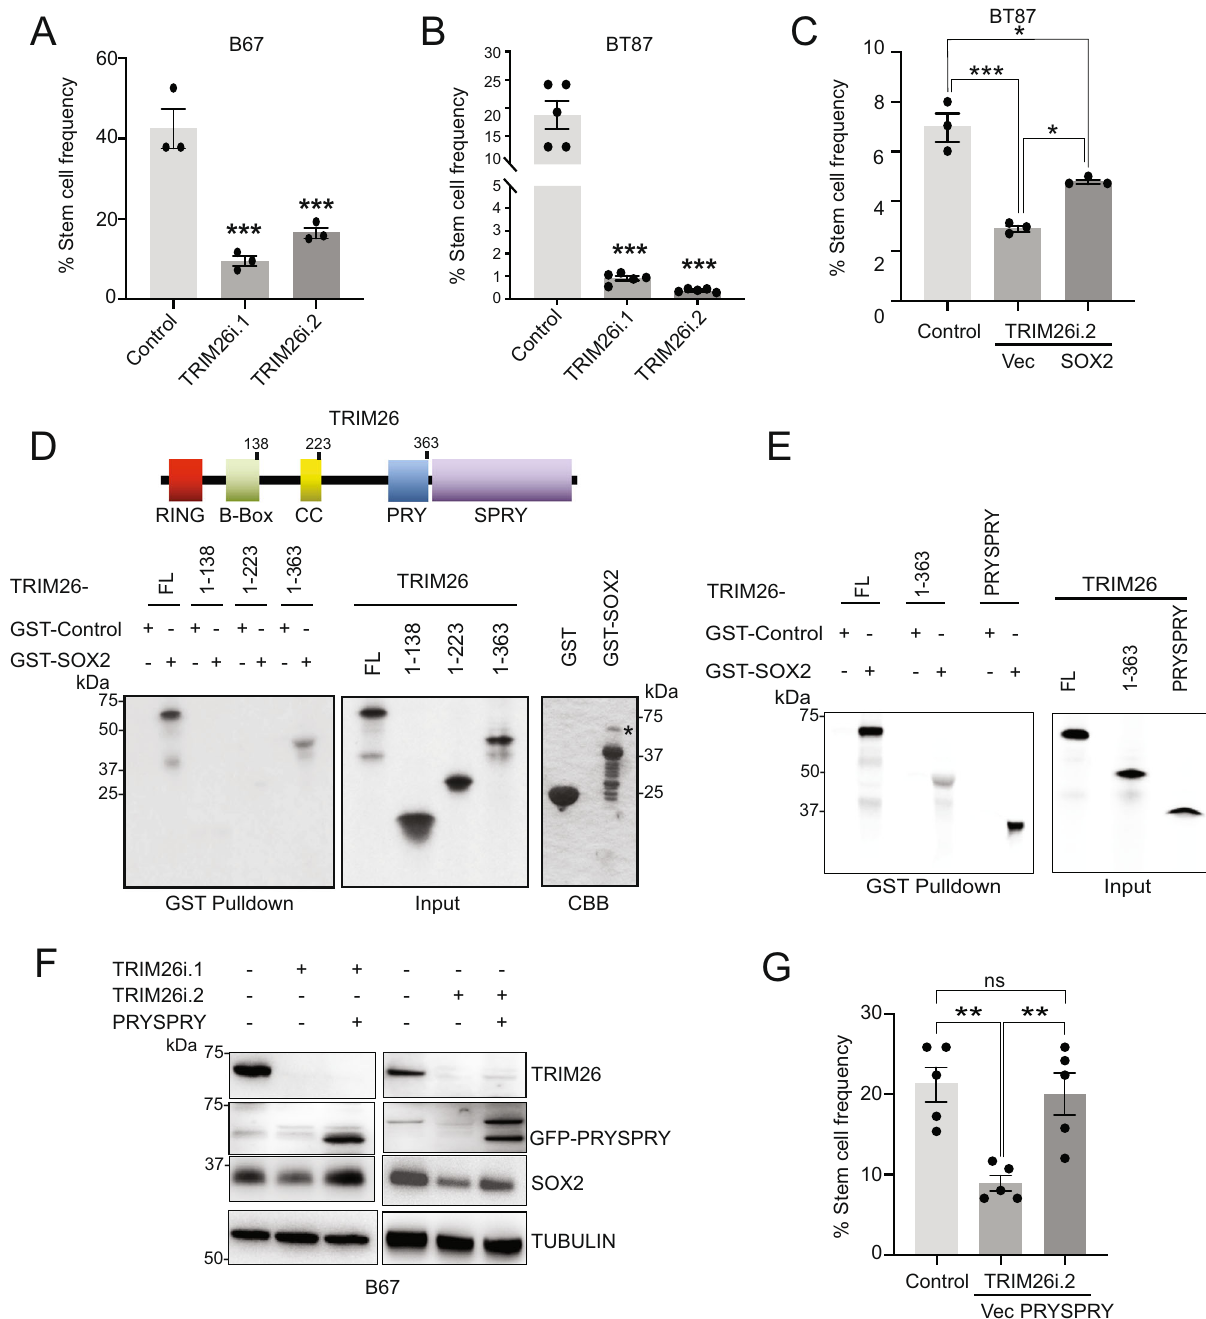
Fig. 3 TRIM26 regulates GSC self-renewal via its C-terminal PRYSPRY domain. A GSCs were transduced with TRIM26 RNAi or control and subjected to the extreme limiting dilution assay (ELDA). Data represent mean ± SEM ( n = 3, ANOVA, *** P < 0.005). See Source Data File for exact P values and statistical parameters. B GSCs treated as in ( A ) were subjected to ELDA. Data represent mean ± SEM ( n = 5, ANOVA, *** P < 0.0001). See Source Data File for exact P values and statistical parameters. C GSCs transduced with TRIM26 RNAi or control were transduced 2 days later with SOX2-expressing or vector (Vec) lentiviruses and subjected to ELDA. Data represent mean ± SEM ( n = 3, ANOVA, * P < 0.05, *** P < 0.0005). See Source Data File for exact P values and statistical parameters. D In vitro translated, 35 S-labeled full-length (FL) TRIM26 and domain deletion mutants were used in GST pulldown assays using glutathione beads and bacterially produced GST control or GST-SOX2 (*FL SOX2). TRIM26 proteins were visualized by gel electrophoresis and fl uorography (middle panel: input). GST-fusion proteins were visualized by Coomassie brilliant blue (CBB) staining. Data were representative of three independent experiments. E In vitro translated, 35 S-labeled full-length (FL) TRIM26, TRIM26 1-363, and TRIM26 PRYSPRY domain were used in GST pulldown assays with GST control or GST-SOX2 as in ( D ). Data were representative of three independent experiments. F GSCs transduced with TRIM26 RNAi or control were treated 2 days later with either vector or TRIM26 GFP-PRYSPRY-expressing lentiviruses. Four days later, lysates were subjected to immunoblotting. Data were representative of three independent experiments. G GSCs transduced with TRIM26 RNAi or control were transduced 2 days later with either vector (Vec) or TRIM26 GFP-PRYSPRY-expressing lentiviruses and then subjected to ELDA as in ( A ). Data represent mean ± SEM ( n = 5, ANOVA, ** P < 0.01, ns nonsigni fi cant). See Source Data File for exact P values and statistical parameters.